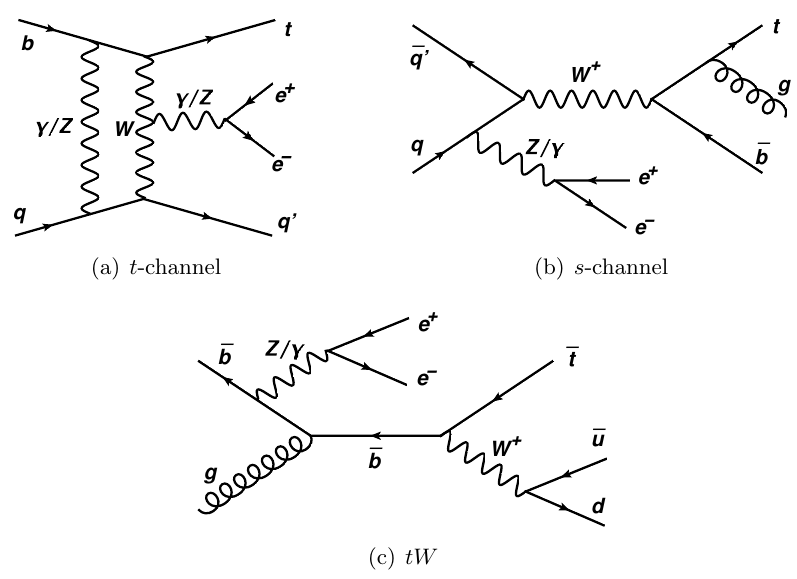
Figure 1 . Representative Feynman diagrams for the di(cid:11)erent channels entering the NLO QCD+EW predictions for t‘ + ‘ (cid:0) j production. The diagram 1(a) contributes to the NLO 2 , while the dia- grams 1(b) and 1(c) contribute to the NLO 1 . Similar diagrams are present for tZj production, while in tHj production the Higgs boson does not couple to the initial-state